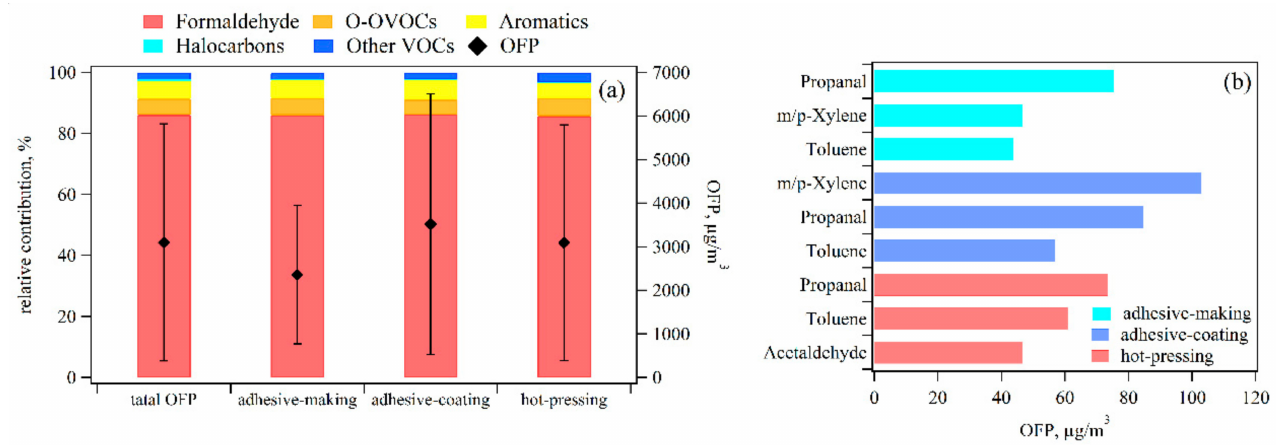
Figure 4. ( a ) The average OFP values of total VOCs and their chemical composition from the plywood manufacturing industry and three processes; ( b ) the VOC species with top three OFP values except for formaldehyde in three processes. The errors bars indicate the standard